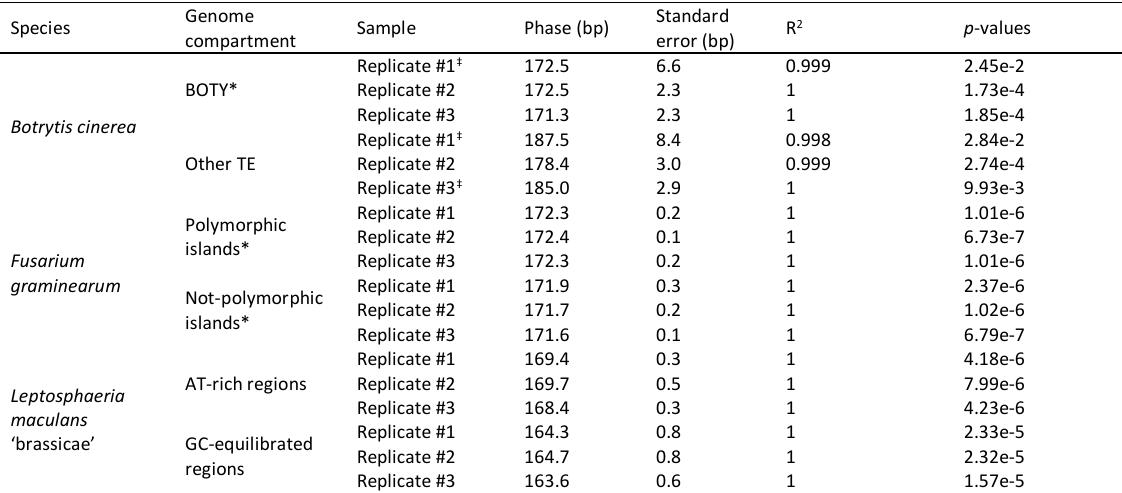
Supplementary Table 3 . Summary of phases, standard errors, coefficient of determination R 2 , and p -values ( F -test) determined after linear regression fitting † in remarkable genome compartments for Botrytis cinerea , Fusarium graminearum , and Leptosphaeria maculans ‘brassicae’ Species